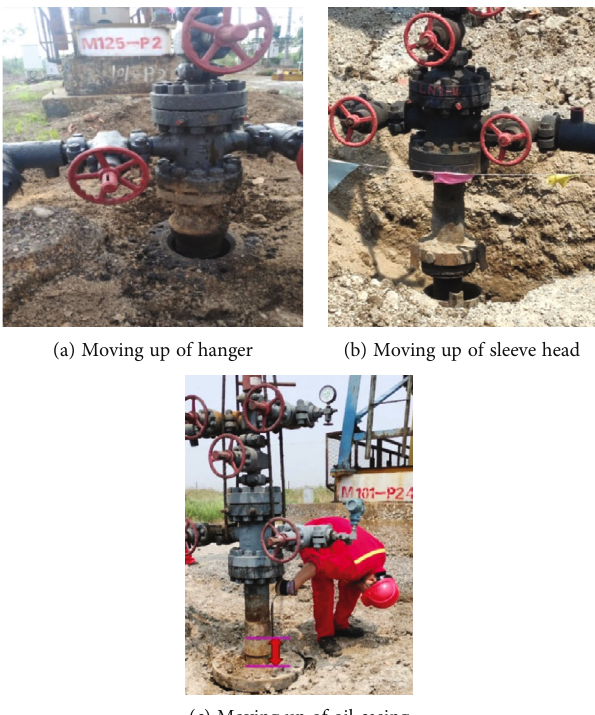
Figure 1: Damage mode of Jidong oil fi eld casing moving